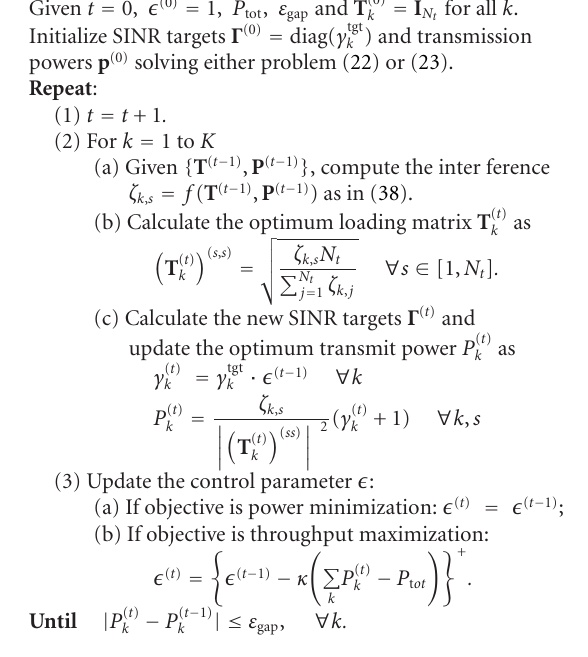
Algorithm 2: Iterative SINR and precoding